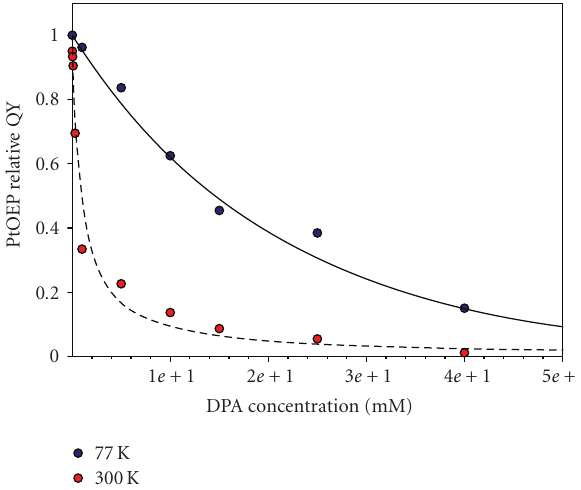
Figure 3: Relative PL quantum yields of the PtOEP PL as a function of the DPA concentration at 77K (blue circles) and 300 K (red circles). The dashed line has been calculated by combining the contribution of the molecular di ff usion and the ET process as a contact interaction. The continuous line is the fit of the data collected at 77K considering a pure Dexter ET (Dexter radius 26.5 ˚A).